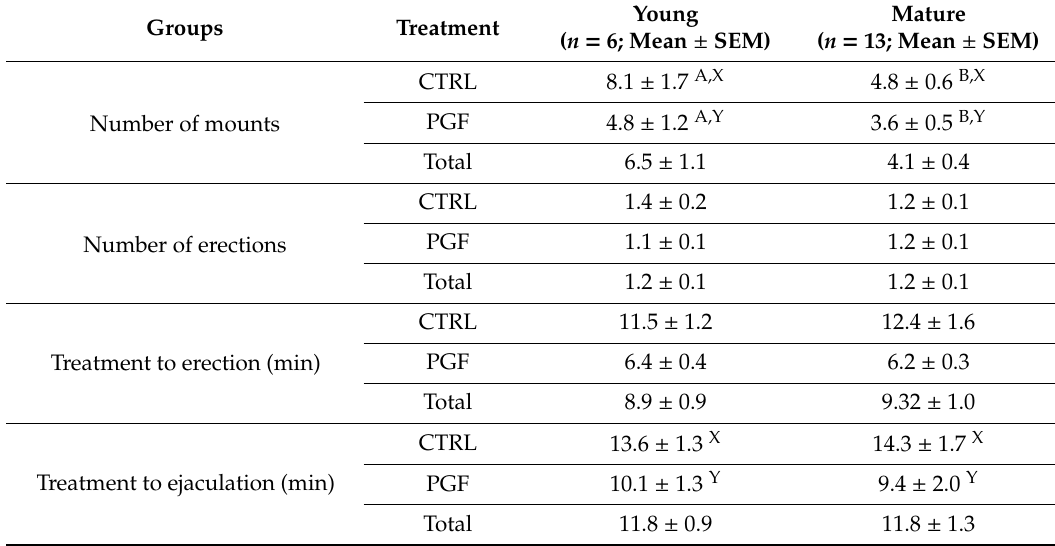
Table 4. Behavioral parameters in 106 semen collections performed in 19 jacks classified as young ( ≤ 5 years old) and mature ( > 5 years old). In half of the collections, jacks were treated with 125 µ g of cloprostenol sodium (PGF) or 1 mL of saline (CTRL) prior to semen collection mounting an estrus jenny.